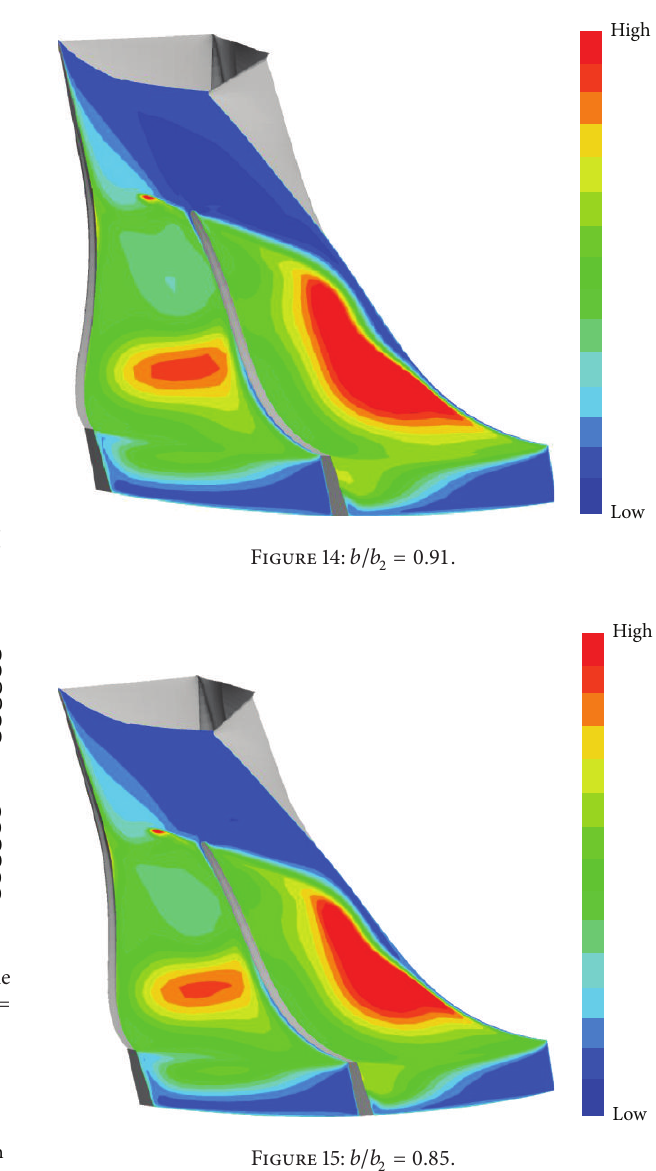
Figure 15: 𝑏/𝑏 2 = 0.85